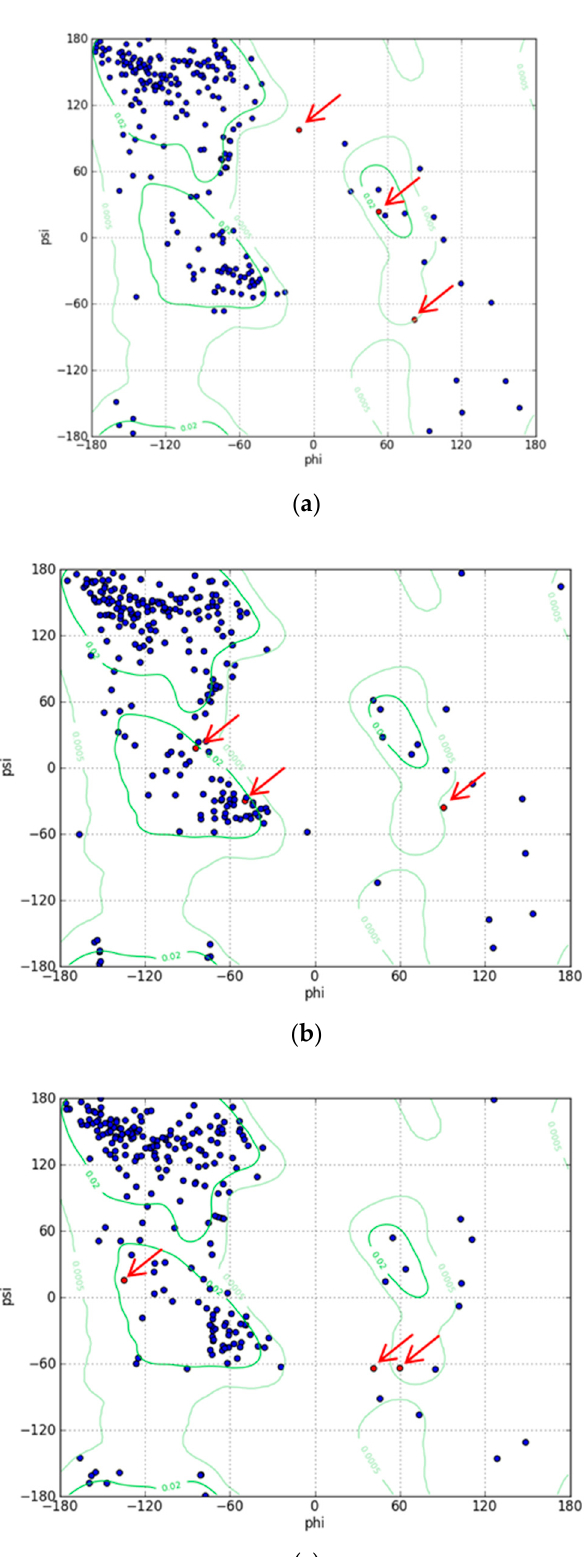
Figure 5. Ramachandran plots for model structures. ( a ) Wild type structure of eGFP. ( b ) Structure of eGFP-loop1. ( c ) Structure of eGFP-loop2. (The three residues, 65T, 66Y, and 67G, in the chromophore are indicated with red arrows).